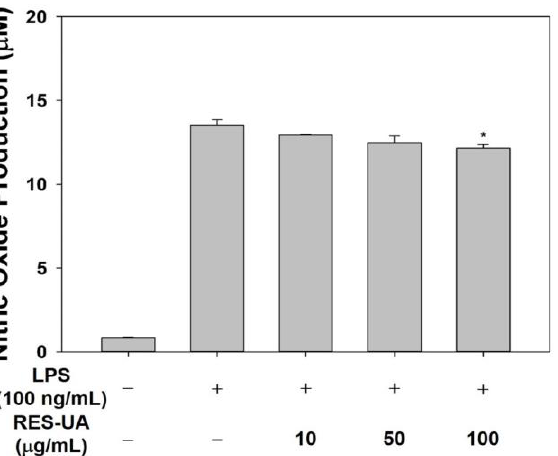
Figure 5. Effect of RES-UA NPs on the production of NO in RAW 264.7 cells. Values are means ± SDs. * p < 0.05; n = 4 per group.